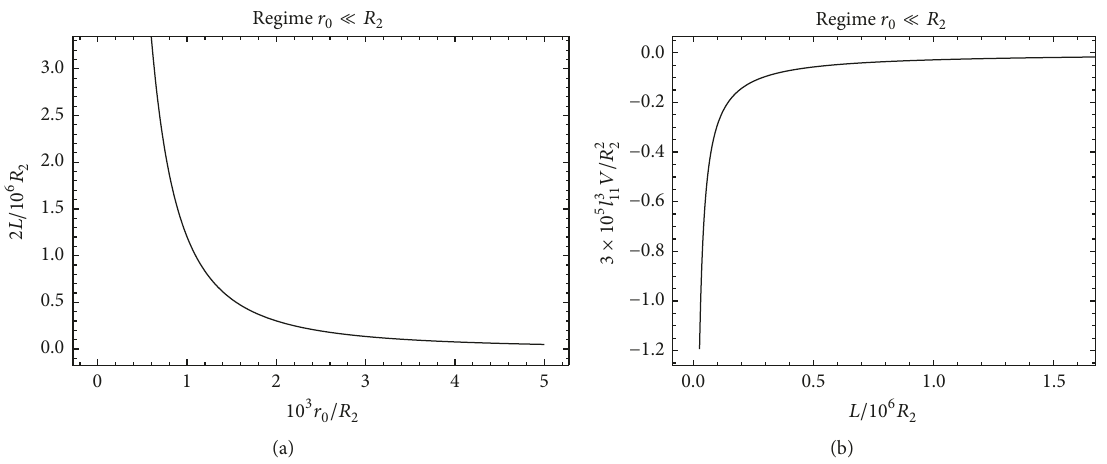
Figure 6: (a) Distance 𝐿/𝑅 2 between quarks in a M2 brane space versus 𝑟 0 /𝑅 where we used 𝑟 1 /𝑅 2 = 10 4 . (b) Potential 𝑙 3 11 𝑉/𝑅 2 2 between quarks in a M2 brane space versus 𝐿/𝑅 2 , where we used 𝑟 1 /𝑅 2 = 10 3 . In both panels 𝑟 0 /𝑅 2 < 5 × 10 −3 .